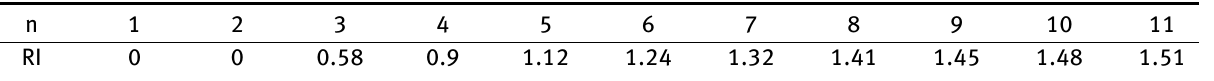
Table 3: Random Index